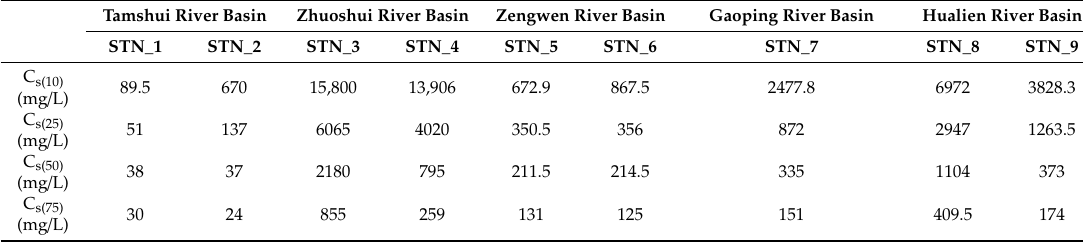
Figure 4. Sediment load and discharge relationships grouped by sediment load (ton/day). Table 5. Thresholds of sediment concentration (mg/L) for gauging stations.